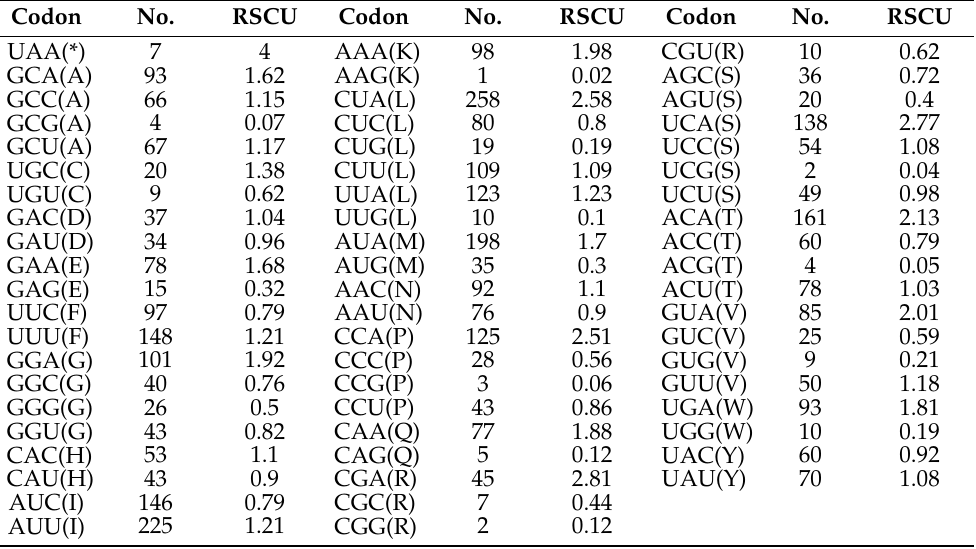
Table 5. The codon usages of Apodemus agrarius ningpoensis